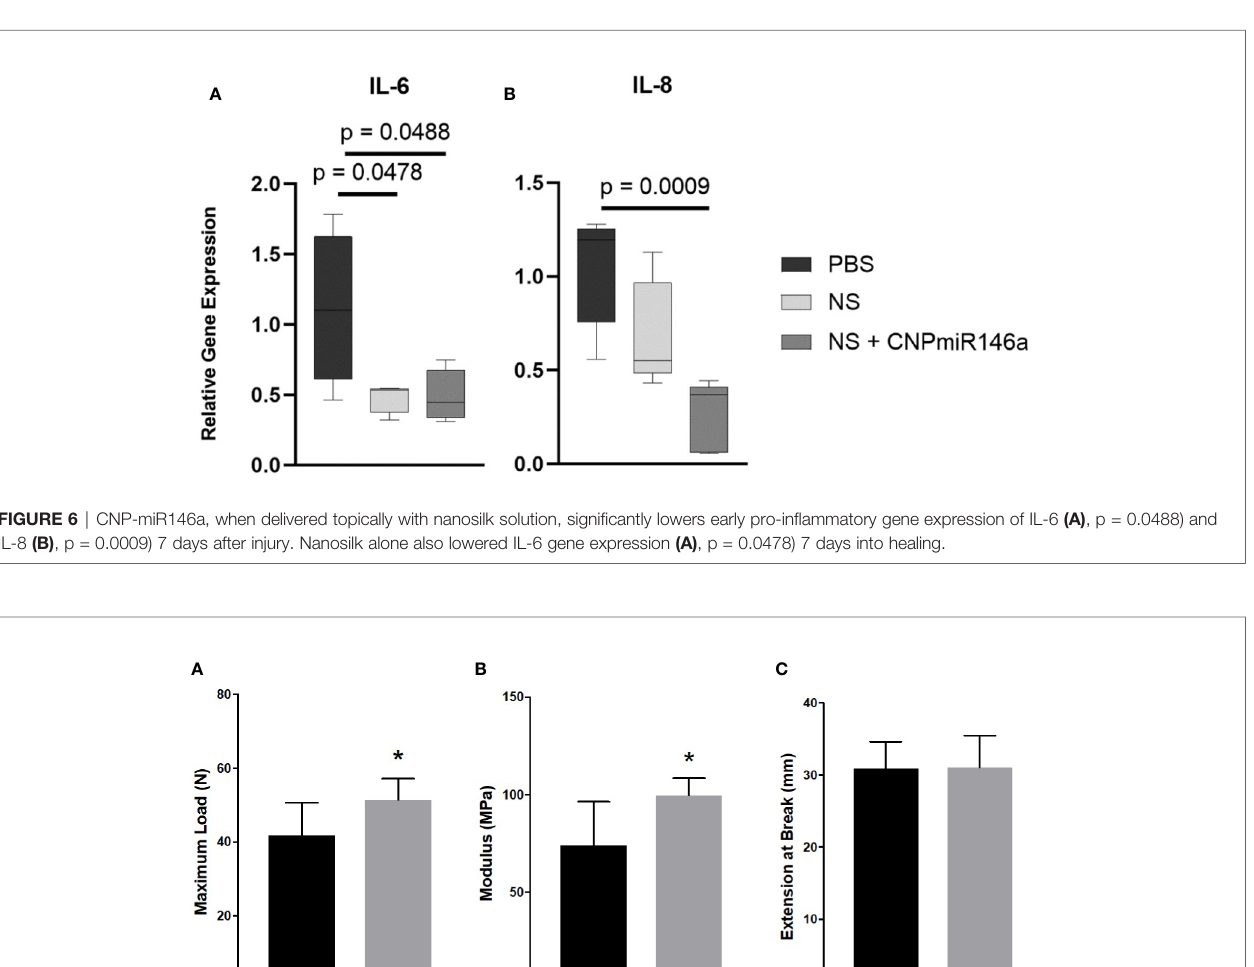
FIGURE 5 | Relative gene expression of pro- fi brotic genes after wounding in diabetic mice. (A) Mice treated with CNP-miR146a had higher expression of TGF b -1 7 days after injury when compared to PBS-treated wounds. (B – C) Fully healed wounds had higher relative expression levels of Col3 a 1 and Col1 a 2 when treated with CNP-miR146a.